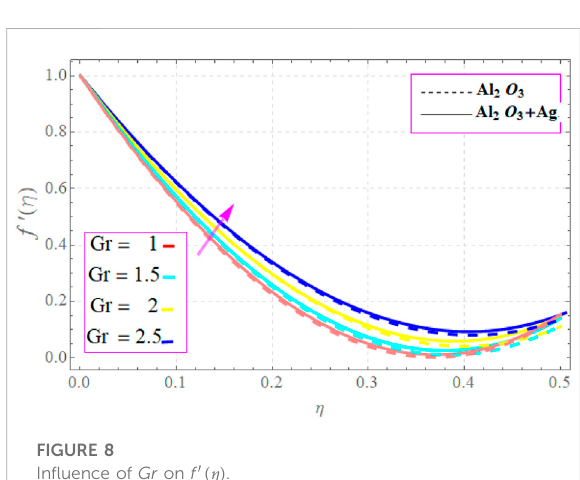
FIGURE 4 In fl uence of ϕ Al